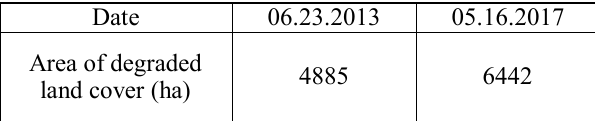
Table 2. Degradation of gold deposits Zaamar area